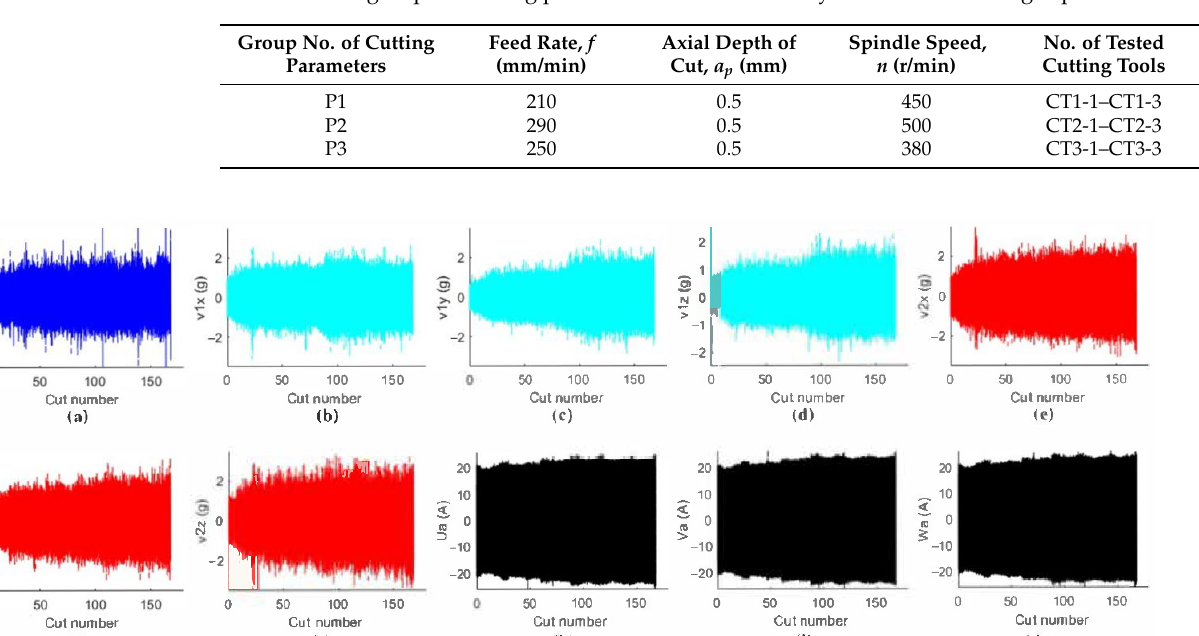
Figure 11. Time-domain waveform of the sensor data: ( a ) Sound pressure signal; ( b ) vibration signals in x-axis on the spindle; ( c ) vibration signals in y-axis on the spindle; ( d ) vibration signals in z-axis on the spindle; ( e ) vibration signals in x-axis on the spindle box; ( f ) vibration signals in y-axis on the spindle box; ( g ) vibration signals in z-axis on the spindle box; ( h ) the u-phase current signal of the spindle controller; ( i ) the v-phase current signal of the spindle controller; ( j ) the w-phase current signal of the spindle controller.